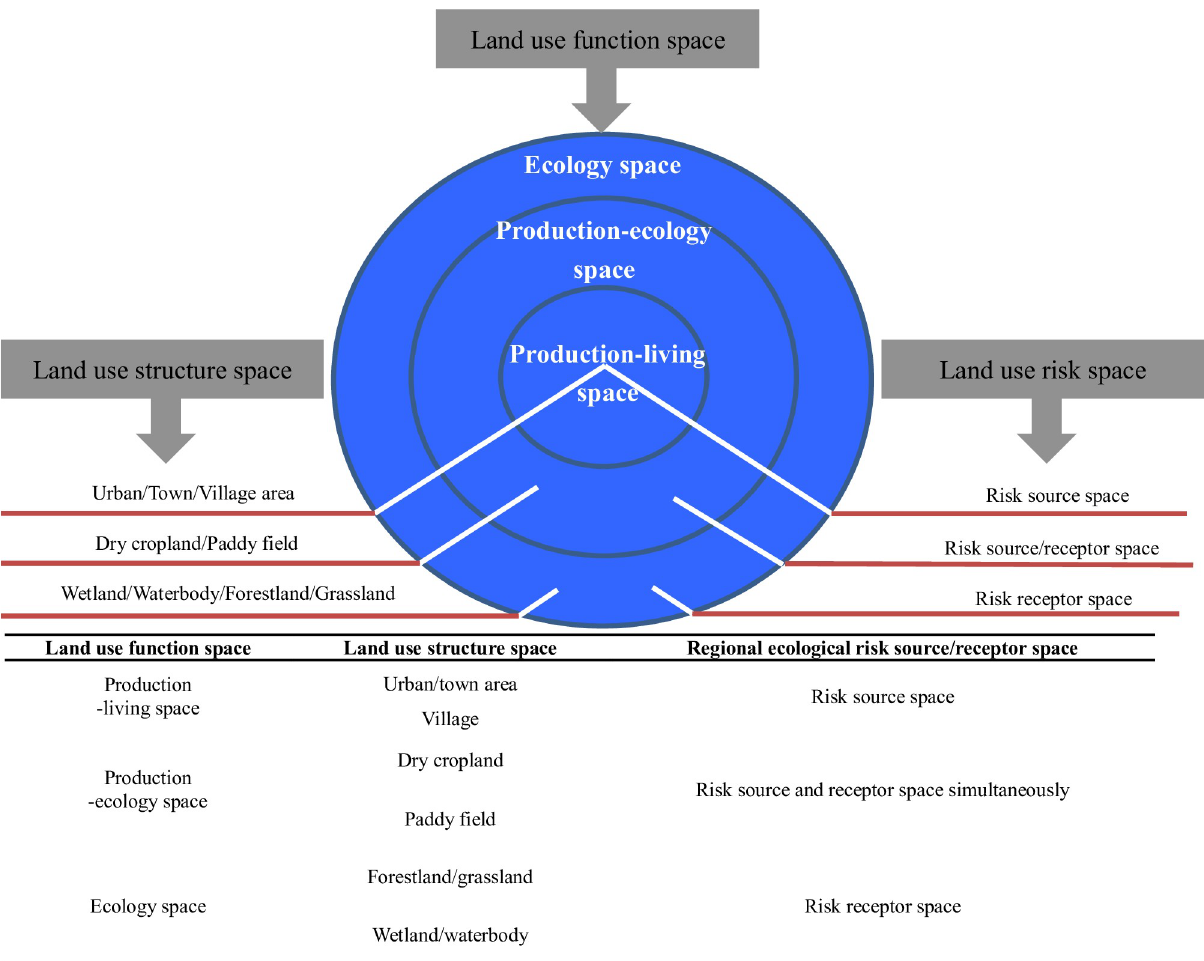
Fig 1. Classification system of regional land use structure, function and risk spaces in this